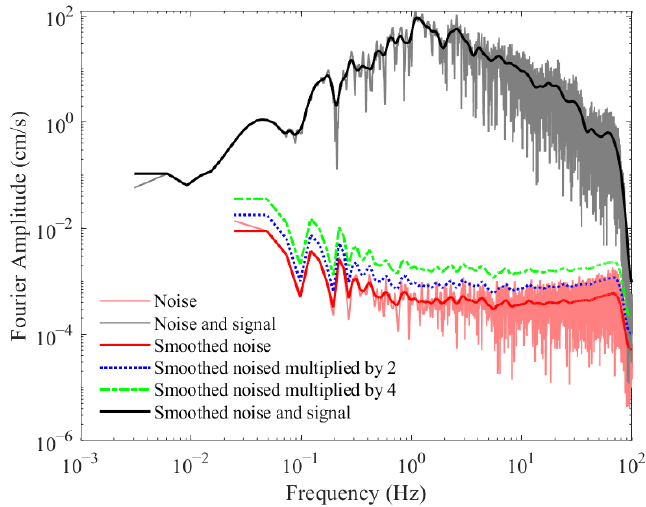
Figure 13. FAS of f HP cannot be obtained via SNR method (AKPWL--n.1000hyfh.HNN.--.V1c).